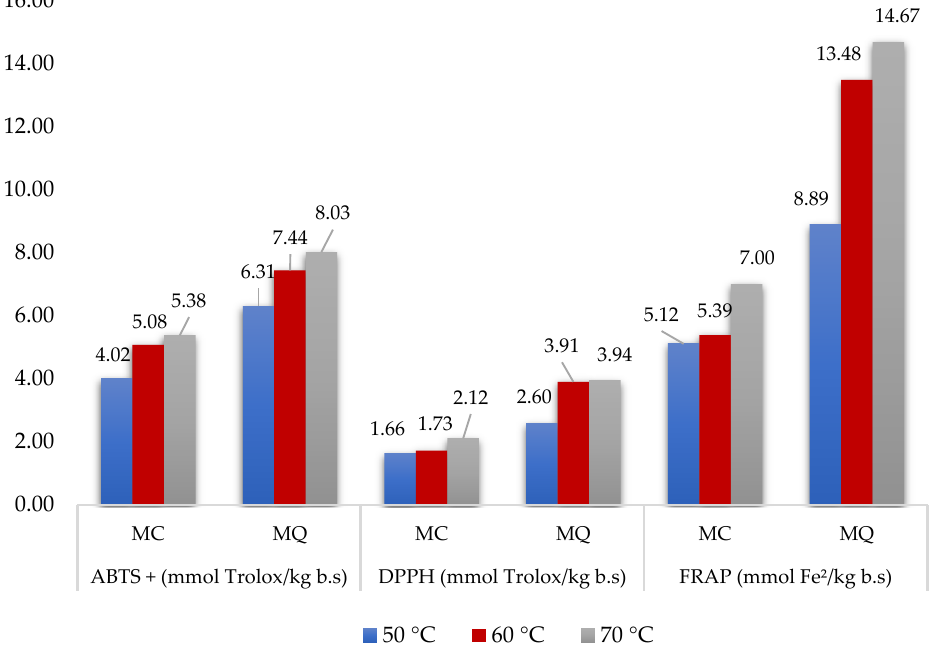
Figure 1. Antioxidant activity of chia (CM) and okra (OM) mucilage powder obtained at different drying temperatures determined by ABTS+, DPPH, and FRAP methods.